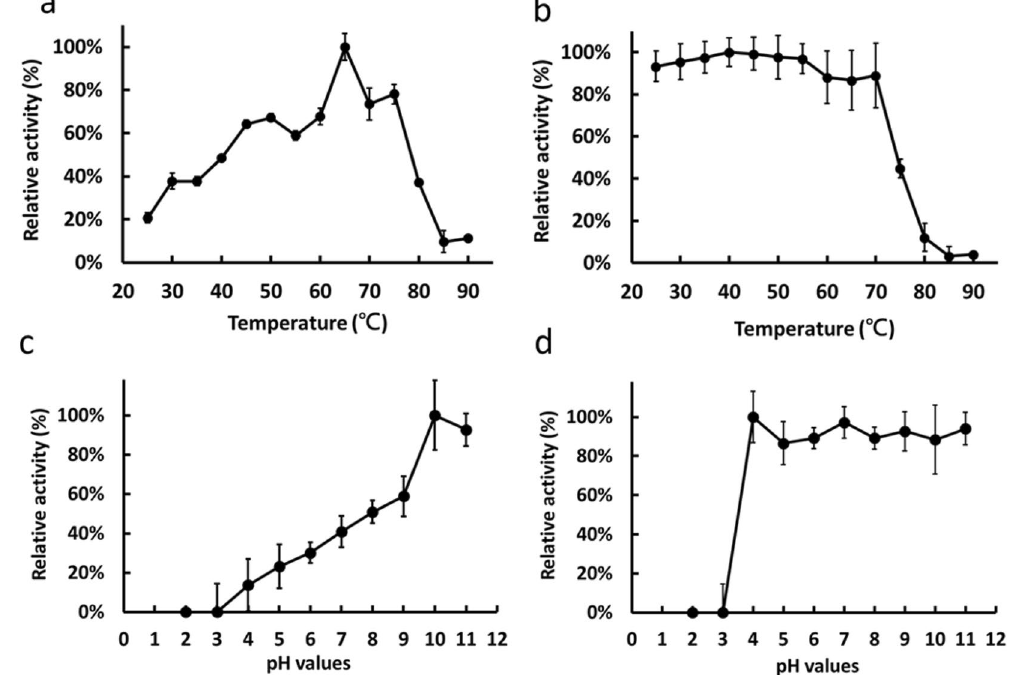
Figure 4. Effects of temperature and pH on the keratinolytic activity and stability of the purified rMtaKer. ( a ) The optimum temperature was detected at different temperatures 25–90 °C for 1 h, using feather keratin as substrate. ( b ) The thermal stability of rMtaKer was measured by pre-heating 5 uM of enzymes at different temperatures for 1 h and assayed under standard conditions at 55 °C. ( c ) The optimum pH of rMtaKer was determined at 55 °C in various pH buffers (pH 2~11). ( d ) The pH stability of rMtaKer was examined by pre- incubating 1 uM rMtaKer in different pH solutions at 25 °C for 1 h and assayed under standard conditions at 55